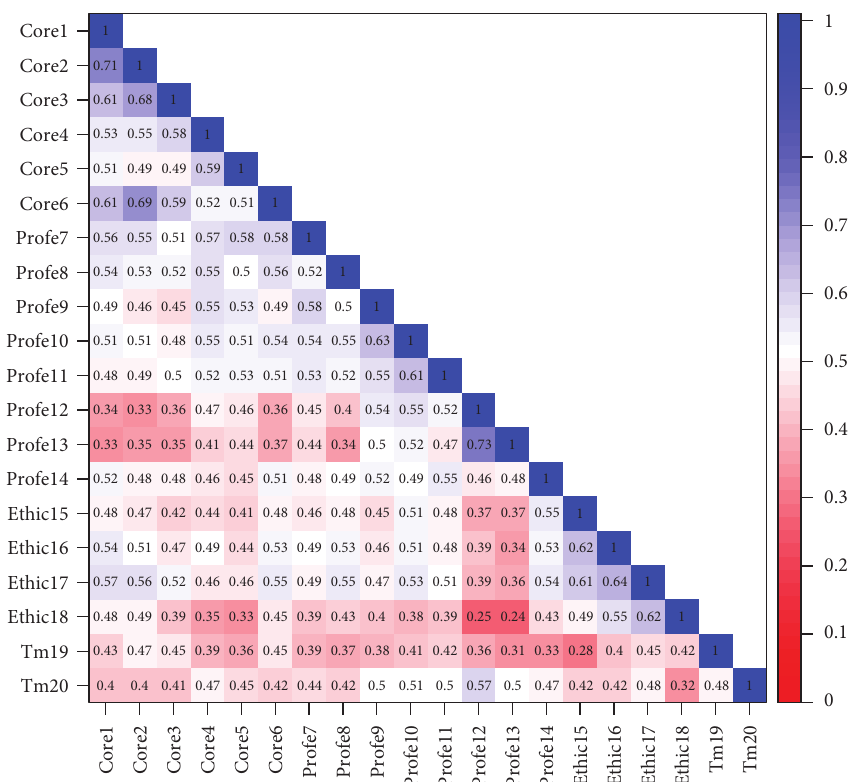
Figure 2: Interitem correlation matrix for SETE scale: The shades of the colors give an idea about the strength of the correlations. A strong positive correlation is indicated by blue color, while a weak positive correlation is indicated by red color. Table 2: Reliability analysis of items (Cronbach’s alpha) and the importance of each item for each construct ( n � 698). Factors and items